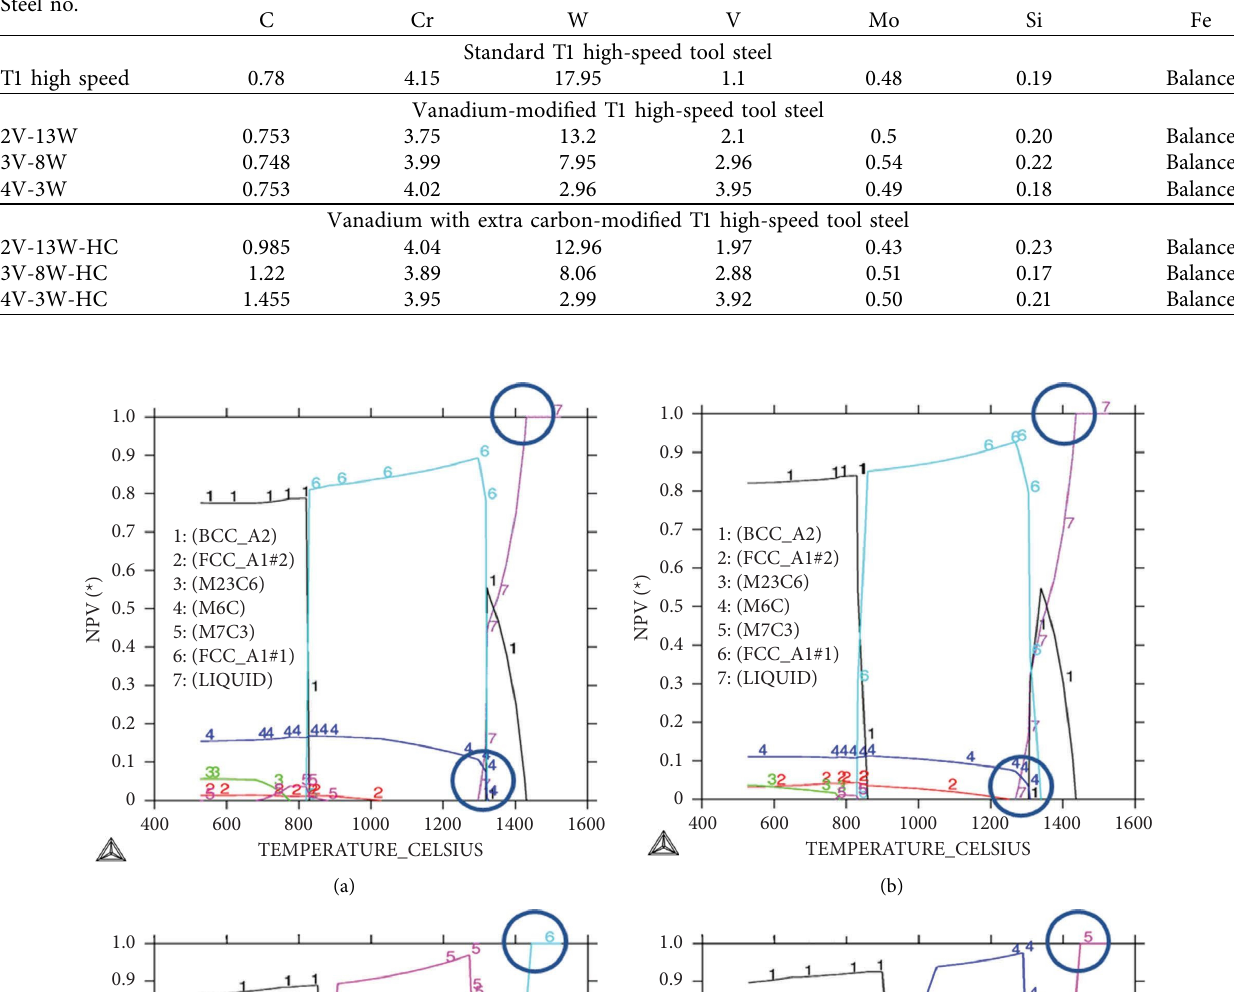
Table 1: Te chemical composition of investigating steel (as solidifed). Steel